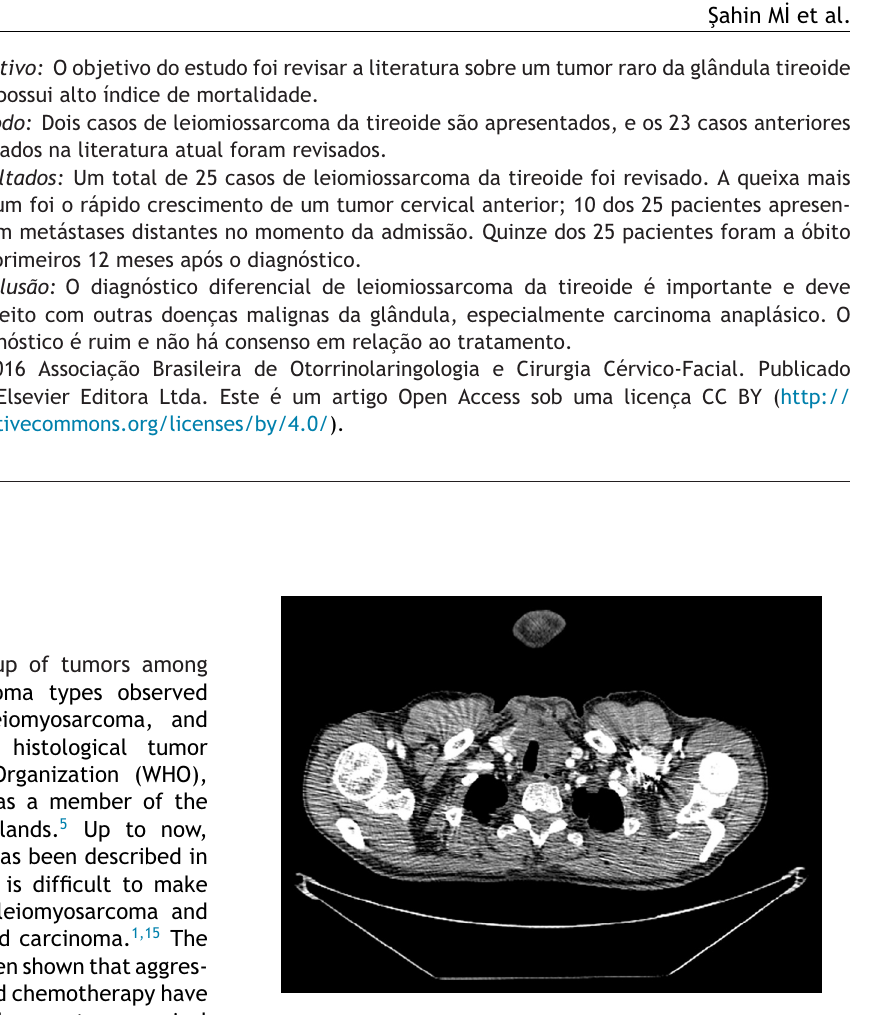
Figure 1 CT scan of the first patient, showing a nodular mass with dystrophic calcification. Histological examination of the specimen showed spin- dle cell tumor with highly cellular fascicles. The tumor infiltrated the adjacent fat and striated muscle. 5---10 mitoses/10 HPF were counted.